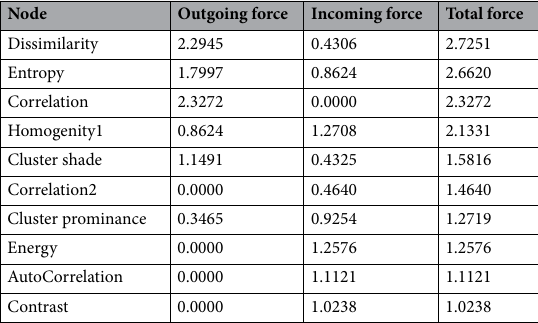
Table 2. Node force of extracted GLCM features from brain